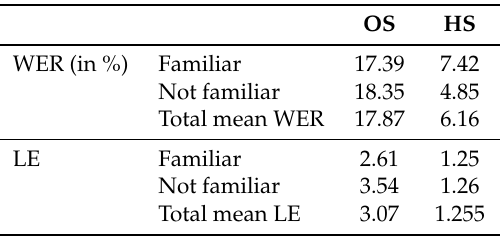
Table 1. Mean Word Error Rate (WER) and Listening Effort (LE) of Oesophageal Speech (OS) and Healthy Speech (HS) for familiar and not familiar listeners .